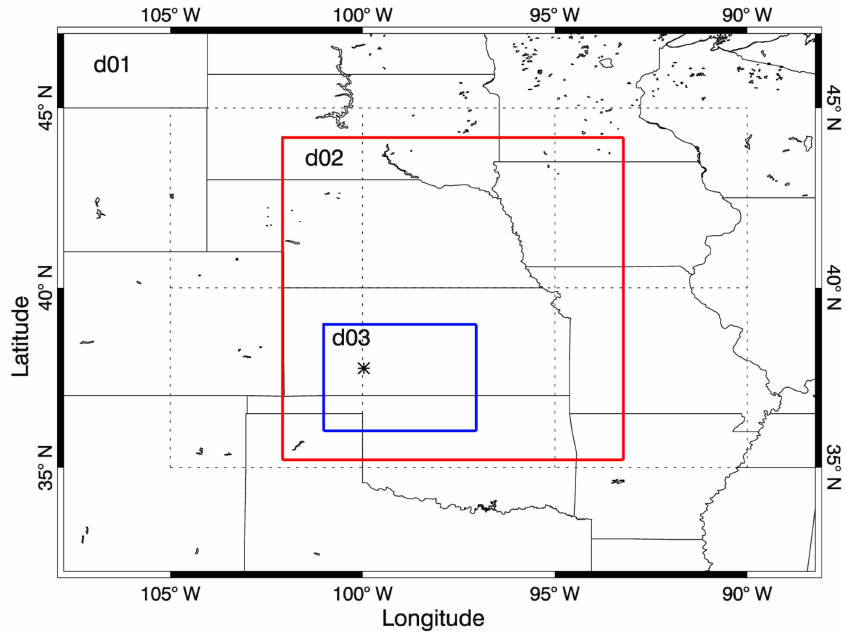
Figure 2. WRF model nested domains for the case study. The black star shows the location of the KDDC